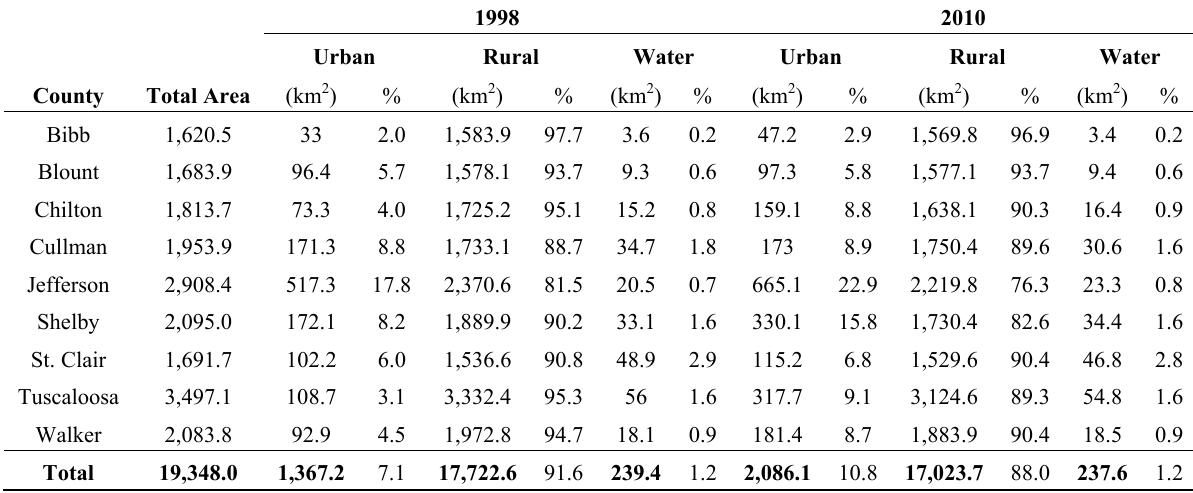
Table 1. Classification statistics for the nine counties in the study region for 1998 and 2010. 1998